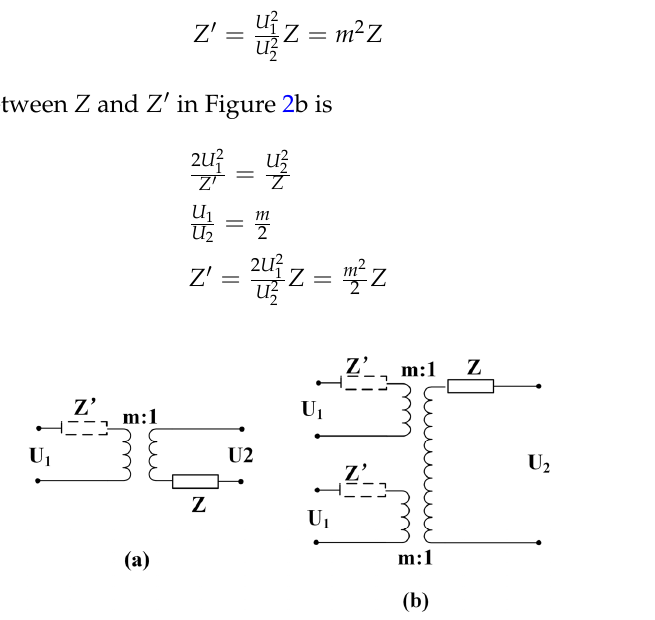
Figure 2. The ideal transformers.